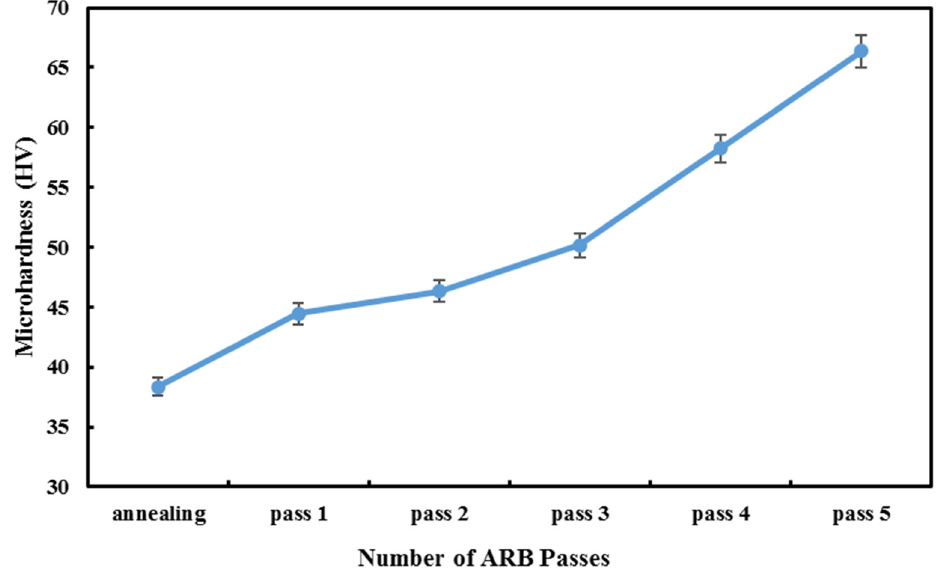
Figure 6. The hardness of ARBed samples and the annealed